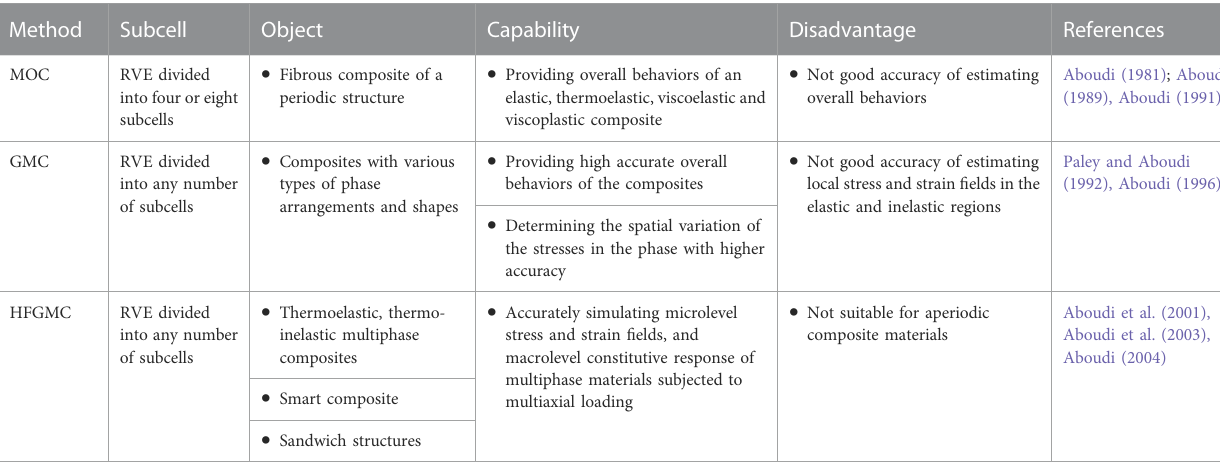
TABLE 1 Comparison of MOC, GMC and